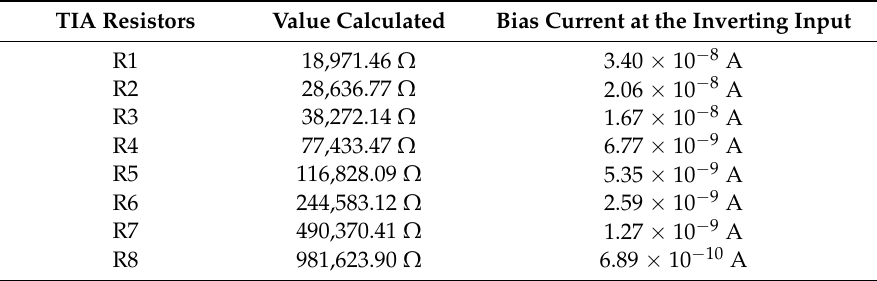
Table 12. TIA resistor calculated and bias current at the inverting